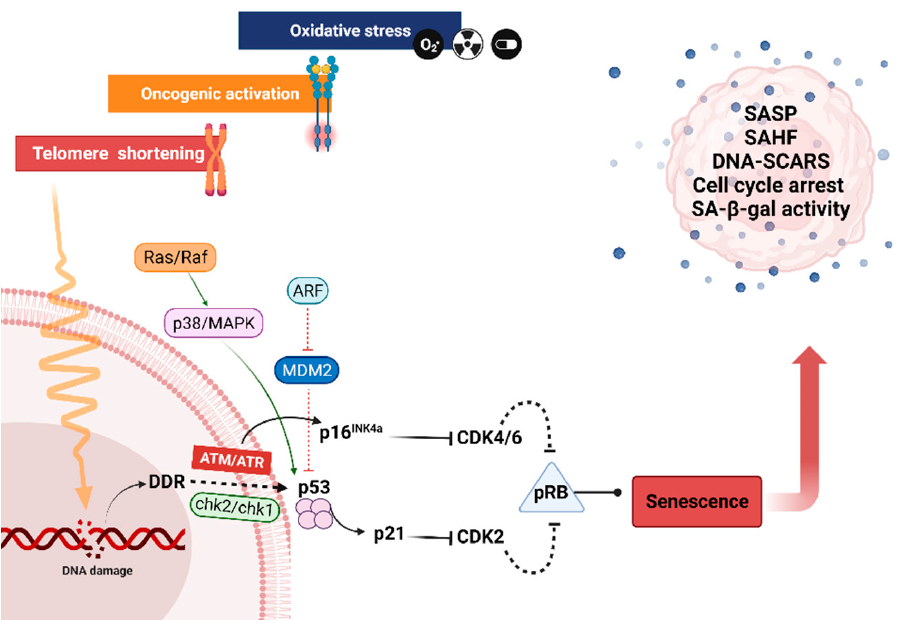
Figure 2. General overview of the different cellular senescence induction pathways and related char- acteristics. Three different types of senescence: replicative senescence, oncogene-induced senescence, and stress-induced senescence involving persistent DNA damage response (DDR).